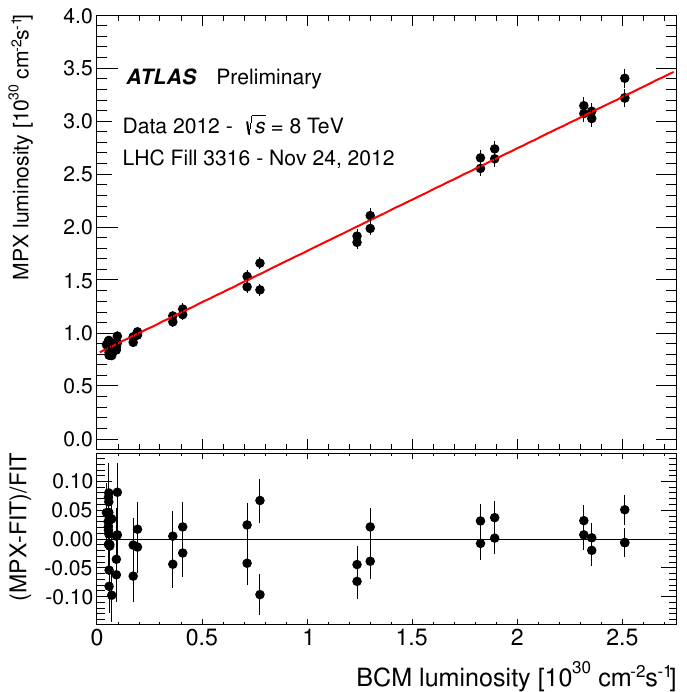
Figure 28. MPX01 hit luminosity vs. BCM luminosity for the last horizontal November 2012 vdM scan. The line is a linear fit to the data. The non-zero intercept corresponds to the difference in the MPX and BCM noise and background contributions. The bottom frame shows the fractional residual of the linear fit. Taken from Ref.